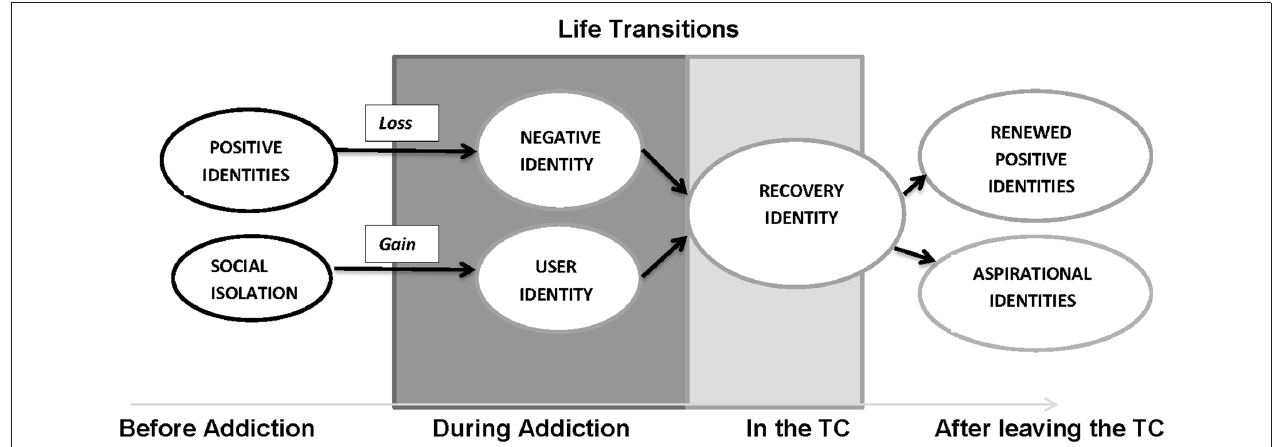
FIGURE 1 | Thematic analysis of interviews with clients in therapeutic drug and alcohol treatment showing changes in social identities over